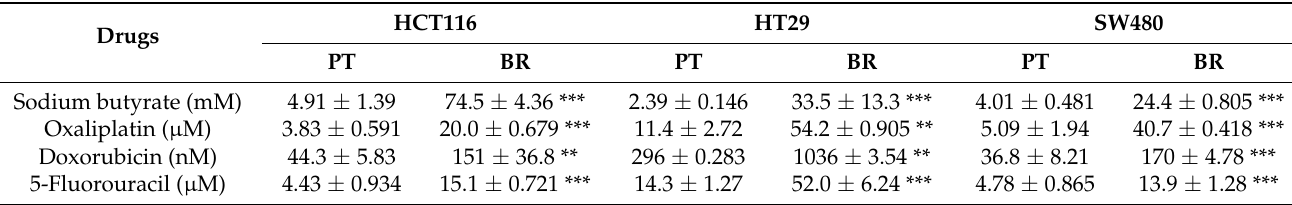
5-Fluorouracil ( µ M)